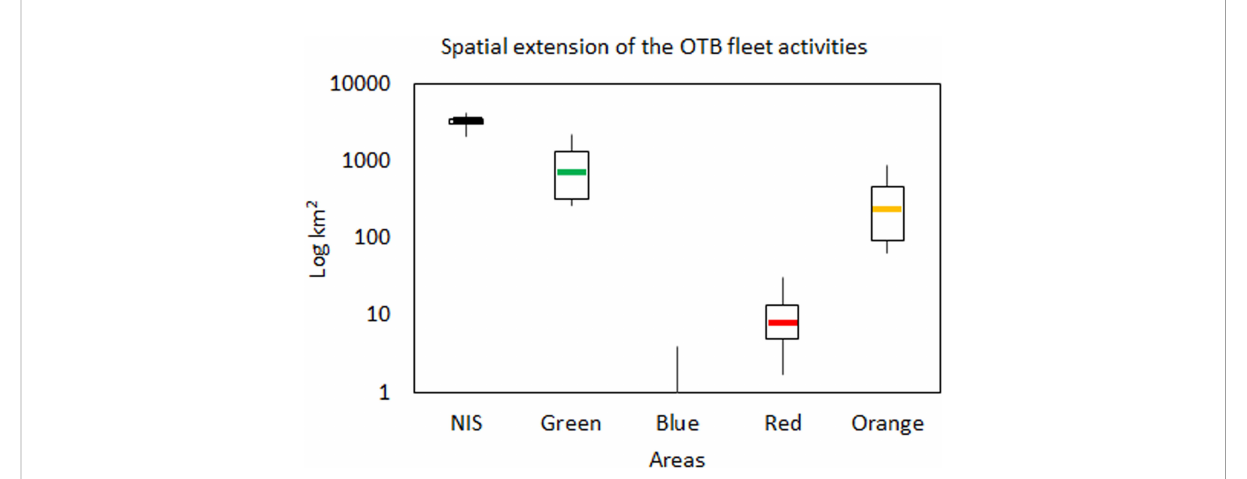
FIGURE 3 The total yearly spatial extension (km 2 in Log scale) of the OTB fl eet within CCAs and the NIS during the investigated period (2016-2019). Boxplots report the median (midline), quartiles (box limits); minimum and maximum values (whiskers out of